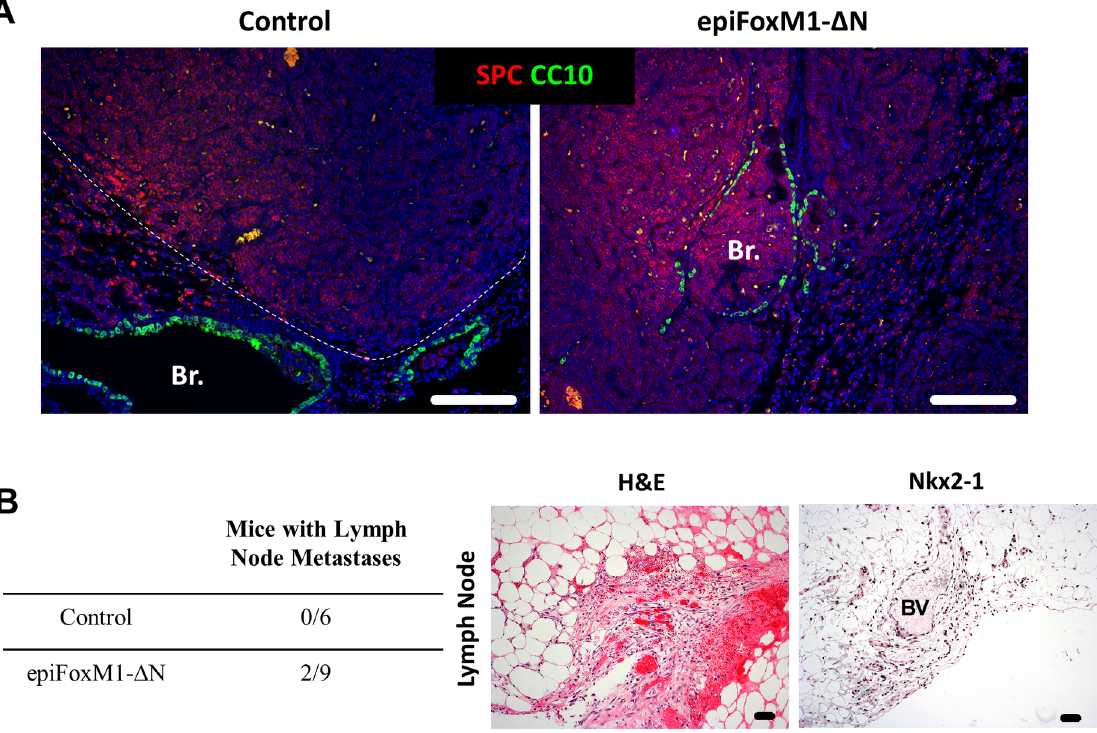
Fig 2. Expression of FOXM1 drives tumor invasion and metastasis. (A) Tumor invasioninto the conductingairways was shown by immunofluorescencestainingfor pro-SPC (tumor cells, red) and CCSP (CC10, bronchiolarepithelium, green). (B) Frequency of peritoneallymph nodemetastases (left panel). None of the control mice (n = 6) developed metastasis. Metastases were found in two epiFoxM1- Δ N mice (n = 9). H&E stainingand NKX2.1 immunostaining of epiFoxM1- Δ N peritonealmetastasis are shown in right